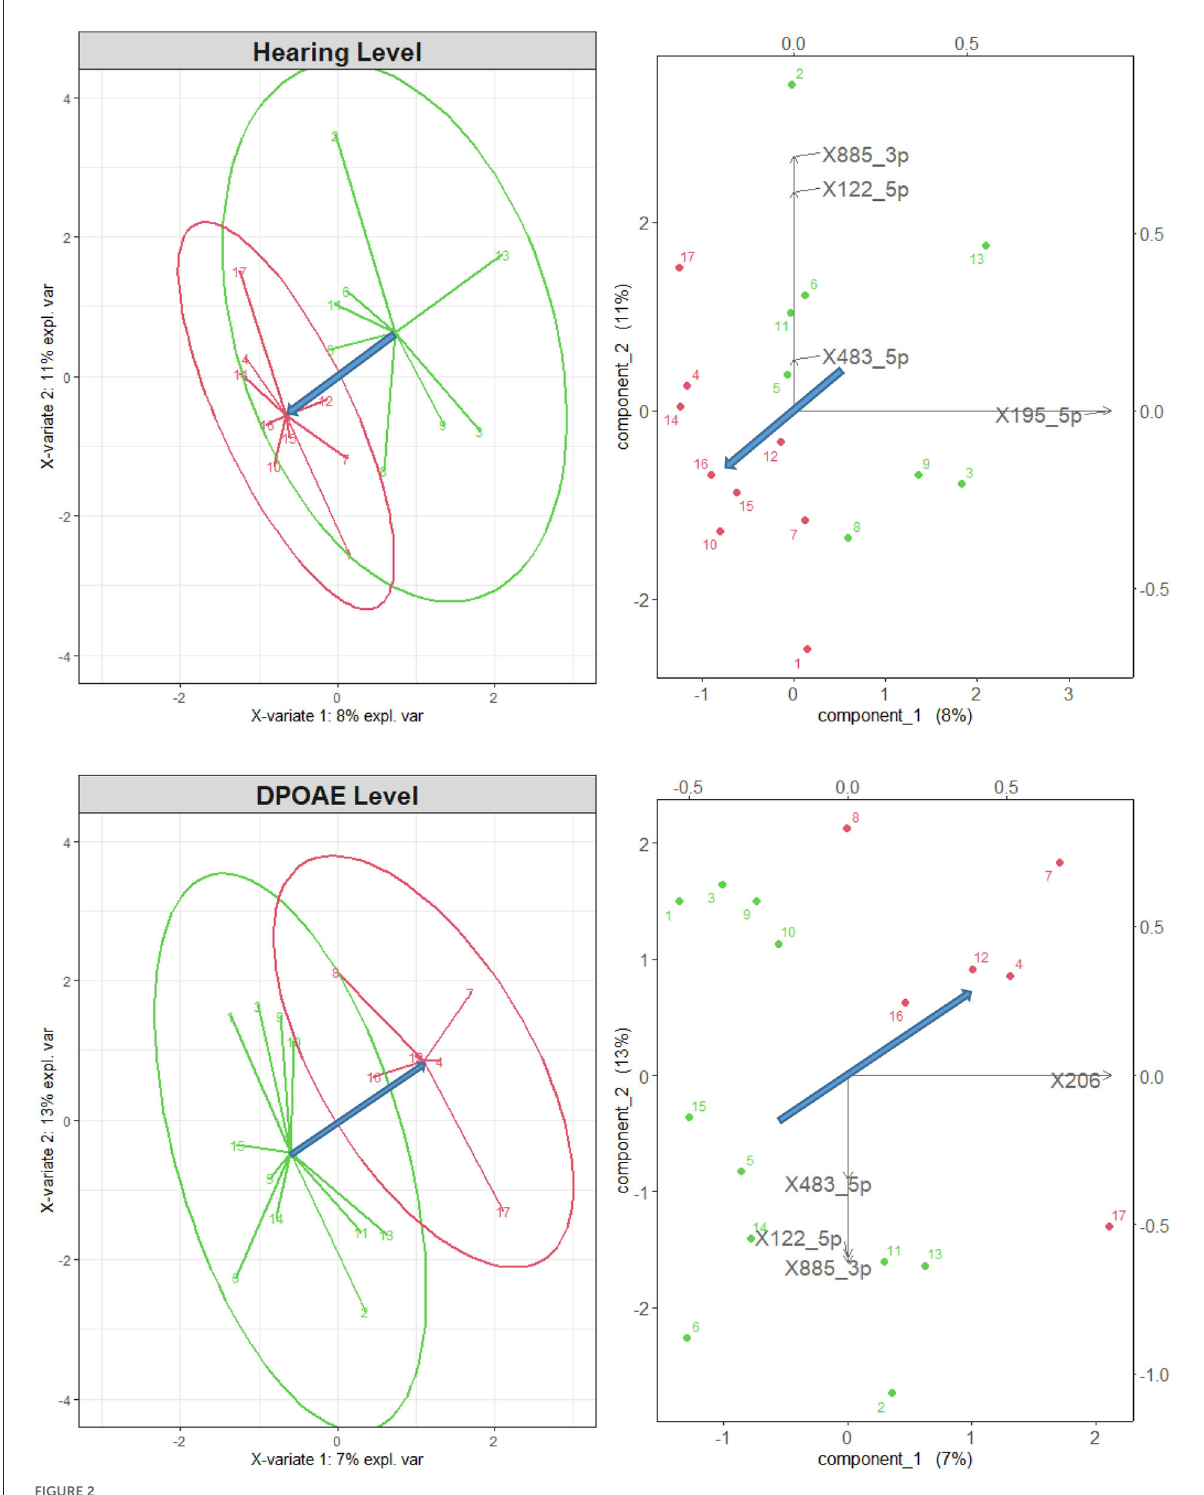
FIGURE2 Left: sPLS-DA for normal-hearing subjects (green points and arrows) and impaired subjects (red), sorted according to their mean audiometric hearing (top) and DPOAE (bottom) level, considering all 56 differentially expressed microRNAs. The two groups are well separated. Right: biplot representation of the original variables in the 2d space of the transformed variables. Only the microRNAs with a correlation higher than 0.75 are shown by the black arrows. The blue arrows represent the direction of maximal discrimination between the two